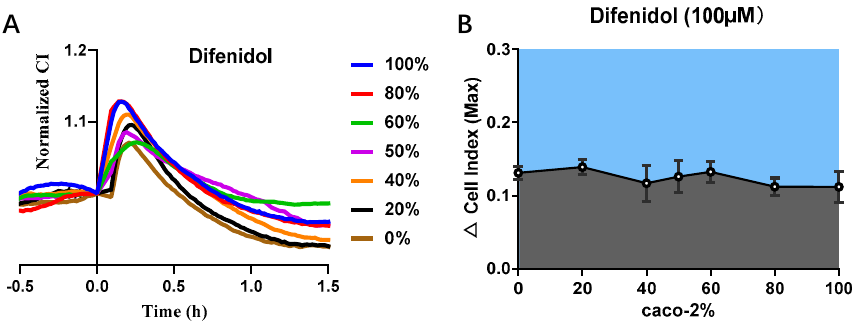
Figure 6. Cell co − culture taste sensor for difenidol detection. ( A ) Impedance response curves to difenidol (100 µ M); ( B ) Continuous evolution profiles (CEP) of